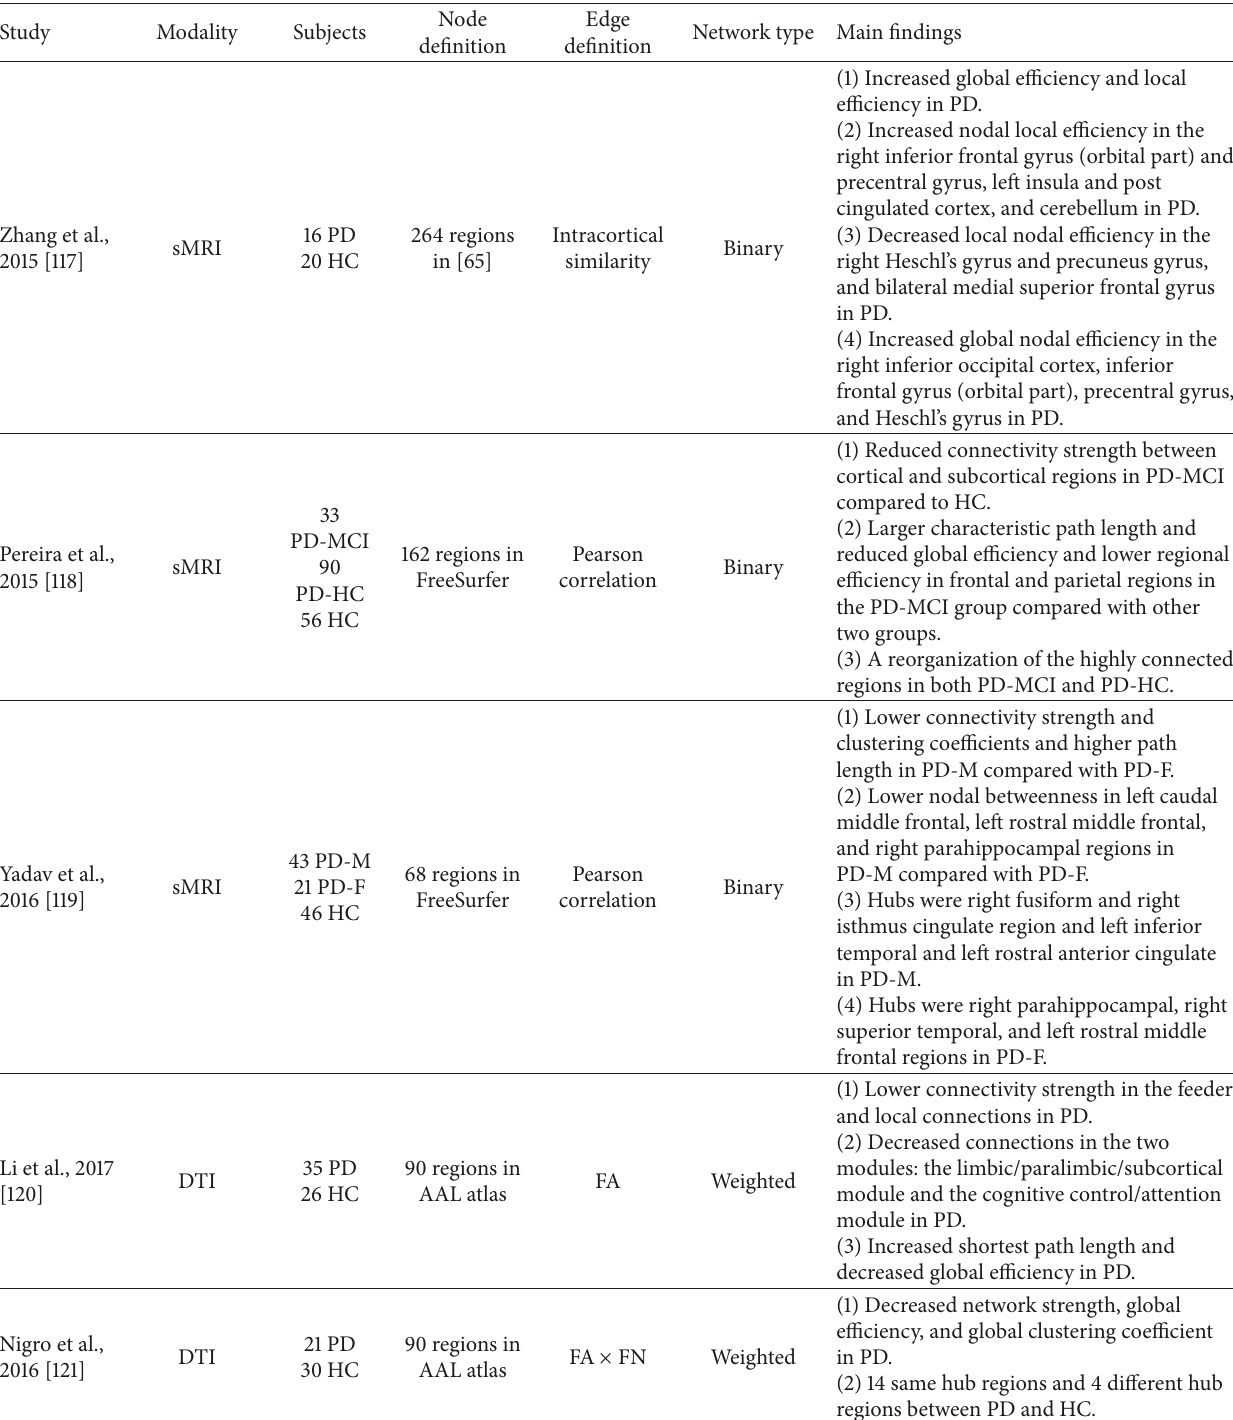
Table 6: Overview of structural brain network studies in